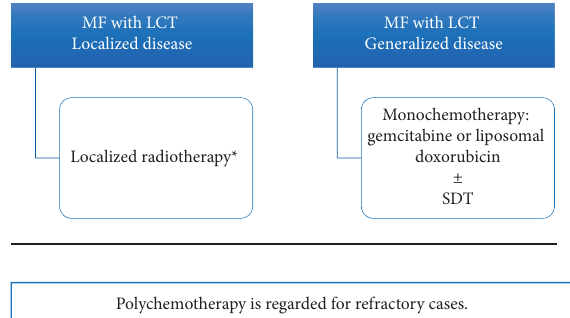
Figure 6: Algorithm for the treatment for MF with LCT. LCT: large cell transformation; SDT: skin-directed therapy. ∗ Other treatment used before transformation can be continued along with